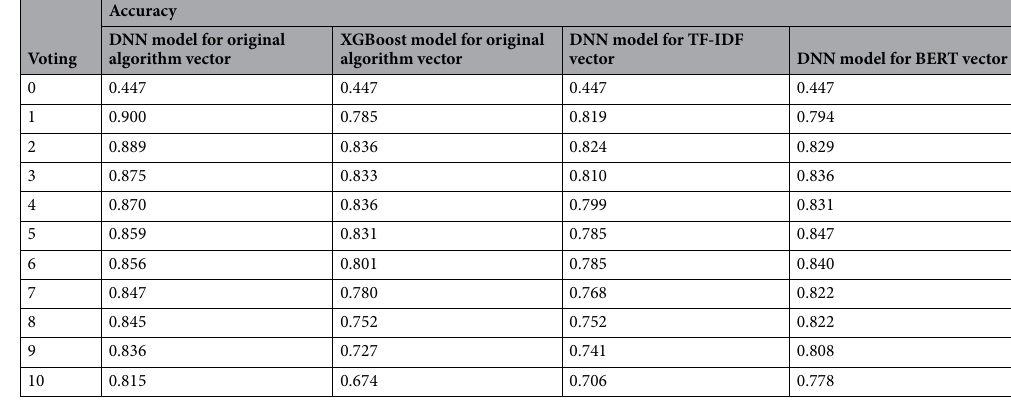
Table 3. Prediction accuracy by voting of XGBoost and DNN model. DNN deep neural network, TF-IDF term frequency–inverse document frequency, BERT bidirectional encoder representations from transformers.